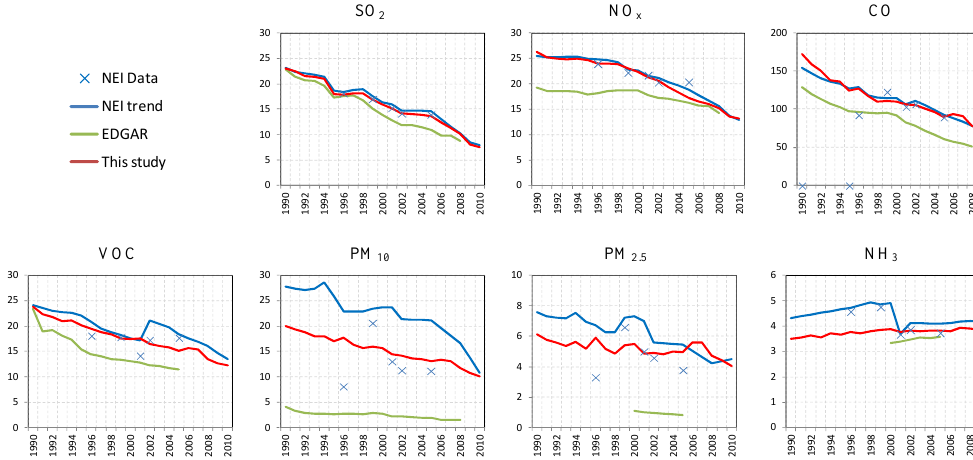
Fig. 9. Emission trends during 1990–2010 (unit:Tgyr − 1 ) . Fig. 9 Emission trends during 1990-2010 (unit: Tg•year -1 )